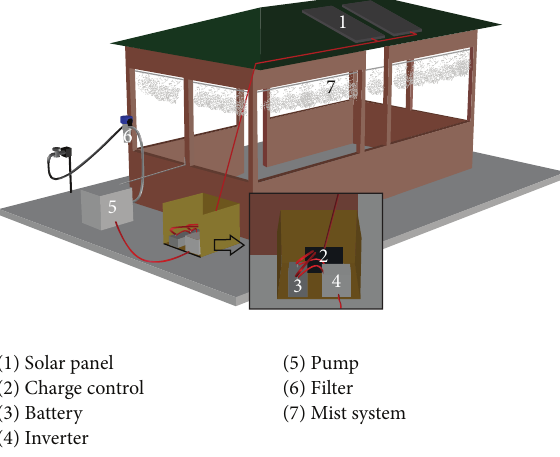
Figure 6: Established experimental system.